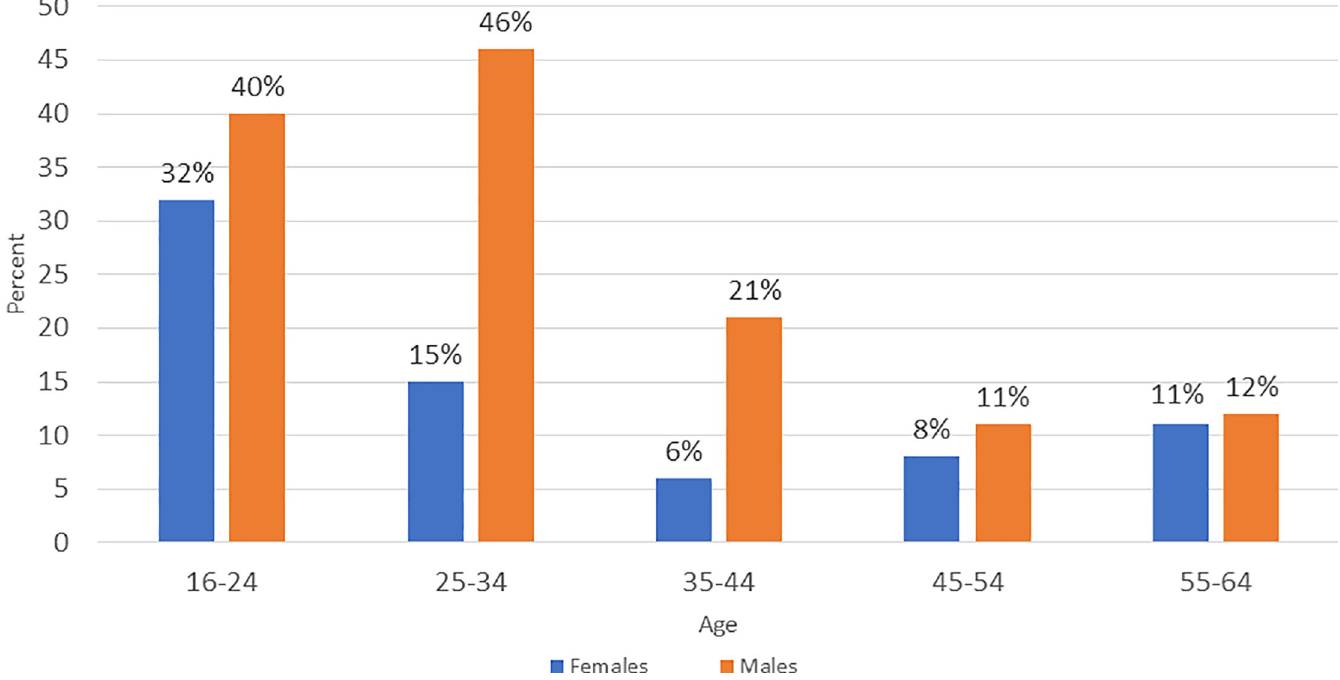
Fig 3. Percentage of new HIV-positive persons among all HIV-positive persons identified by sex & age in 15 intervention communities.